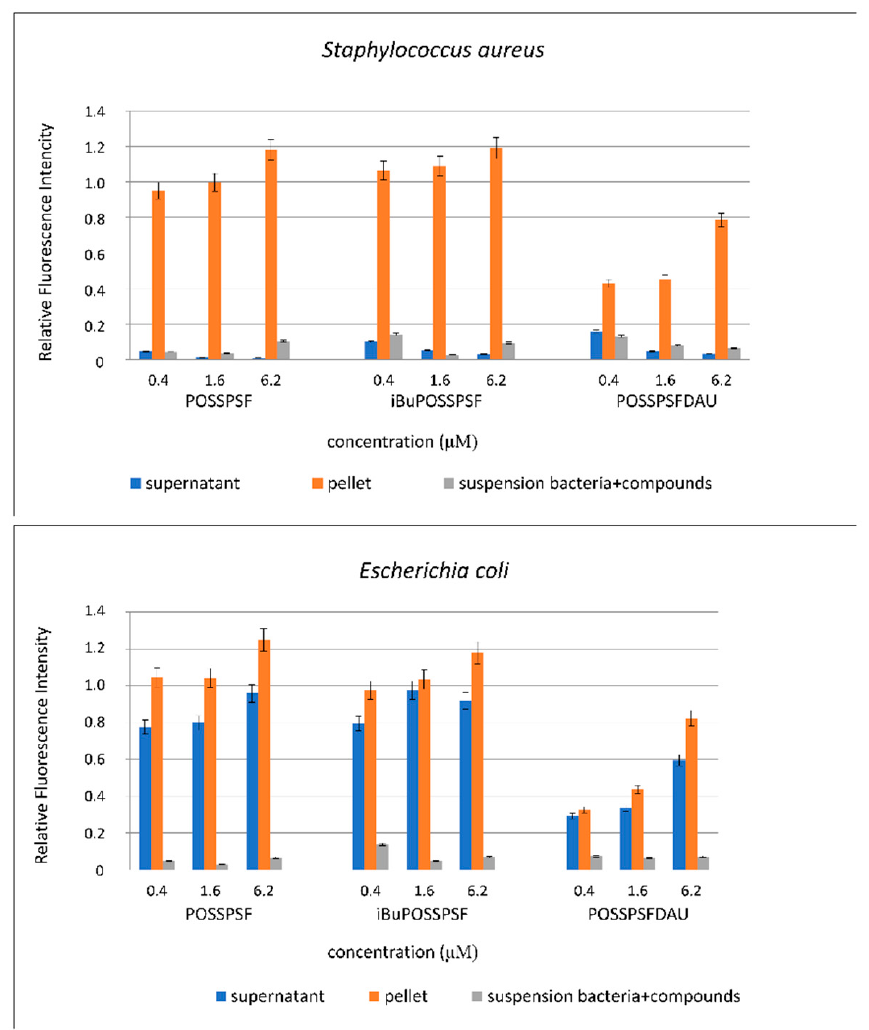
Figure 10. Fluorescence intensity of S. aureus and E. coli cells suspension, pellet and supernatant incubated in the presence of different concentration of POSSPSF, iBuPOSSPSF and POSSPSFDAU. Relative fluorescence intensity was calculated to the fluorescence of photosensitizers solution. To visualize the effect of POSSPSF, iBuPOSSPSF and POSSPSFDAU on bacterial cell, transmission electron microscopy was also carried out (Figure 11). For these tests, S. aureus MRSA 12673 and E. coli 12519 cells were selected. The images of the bacterial cells treated with tested compounds showed distortion in the shape and morphology, while the regular shape of the control cells was clearly visible. Some cells turned from the normal round (Figure 11A) or rod-shaped (Figure 11B) into irregular shapes presenting broken and lysed cells with the cellular mass leaking out ( S. aureus strain MRSA), black arrows) (Figure 11A). The E. coli cells have become distorted and thickenings are visible in some places (Figure 11B). The cells coated with tested compounds are also visible (indicated by white arrow). Changes in bacterial cell morphology can indicate that cell membrane permeability was disrupted or/and the structure of the cell wall was disintegrated (more figures are introduced to the Supplementary Materials, Figure